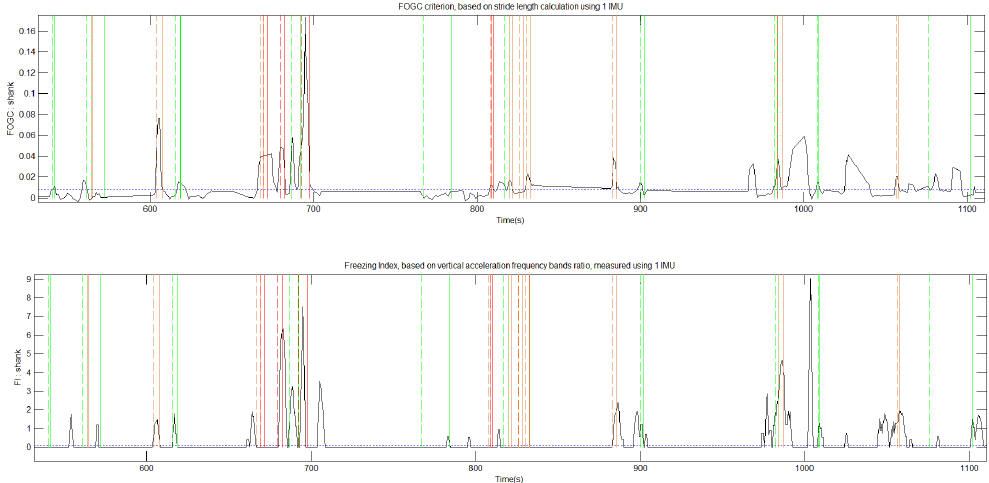
Figure 3. FOGC ( Top ) and FI ( Bottom ) were calculated from inertial measures provided by one IMU placed at ankle. Based on video recordings, the FOG events were classified from green to red (vertical lines), regarding their intensity. A FOG detection threshold is set to 0.008 for the FOGC and 0.1 for the FI (horizontal blue lines), with a 4 s NFFT